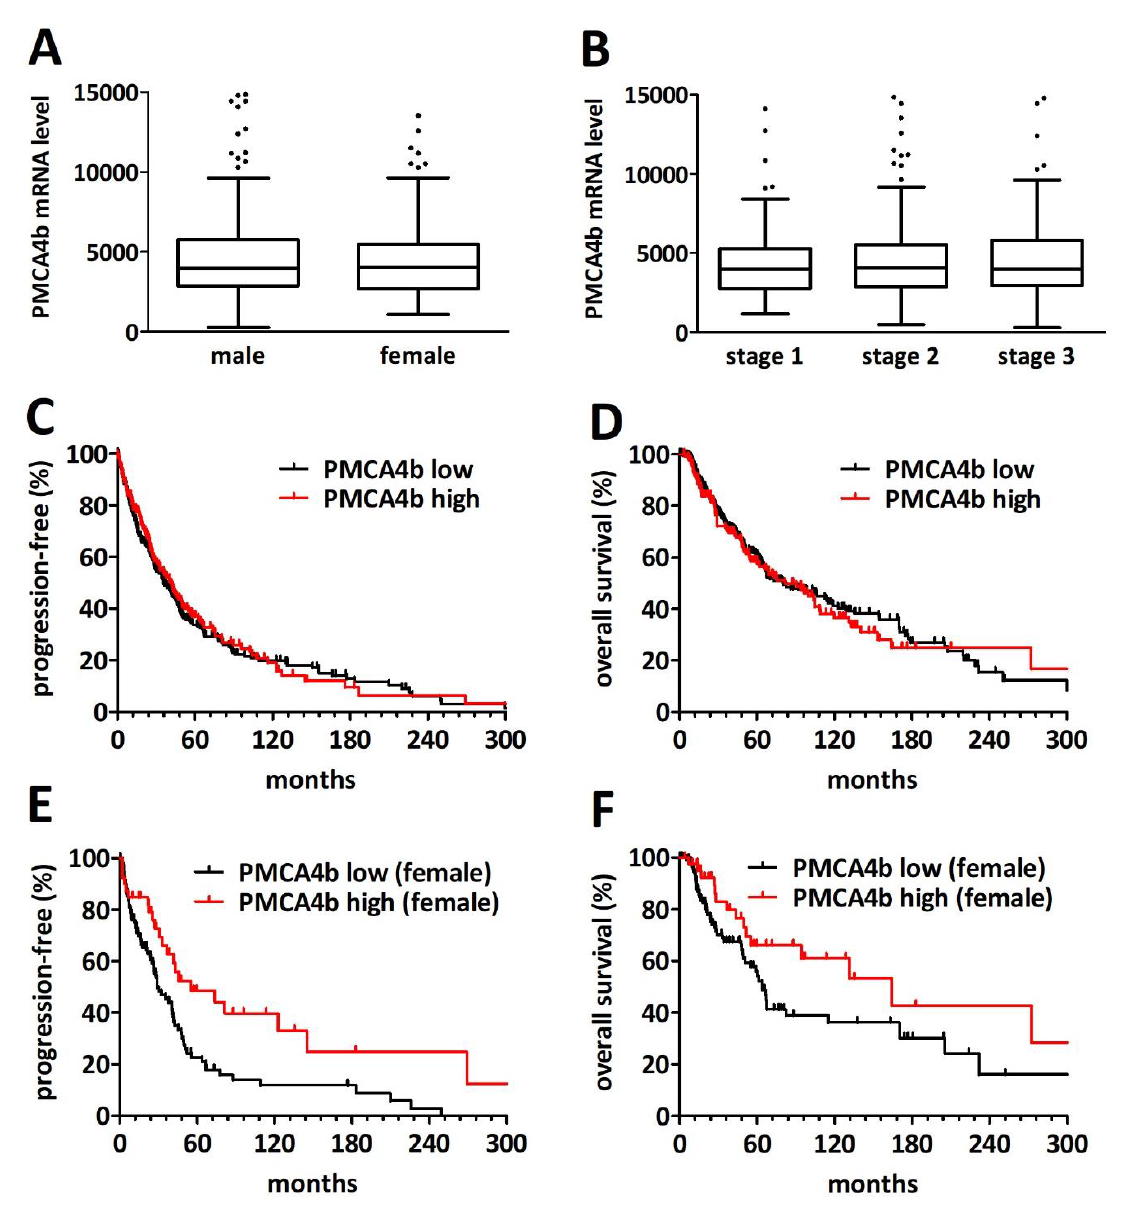
Figure 4. PMCA4 is a gender specific prognostic factor in the TCGA cohort of non-metastatic cutaneous melanoma patients. ( A ) There is no difference in the distribution of PMCA4 mRNA levels between male and female patients. ( B ) PMCA4 mRNA levels are independent of disease stage. ( C , D ) PMCA4 levels show no association with progression-free ( C ) or overall ( D ) survival in the overall cohort. ( E ) In female patients, high PMCA4 levels confer a significantly longer progression-free survival ( p = 0.0037). ( F ) The difference in overall survival in female patients between high and low PMCA4 mRNA levels did not reach statistical significance ( p = 0.0717).